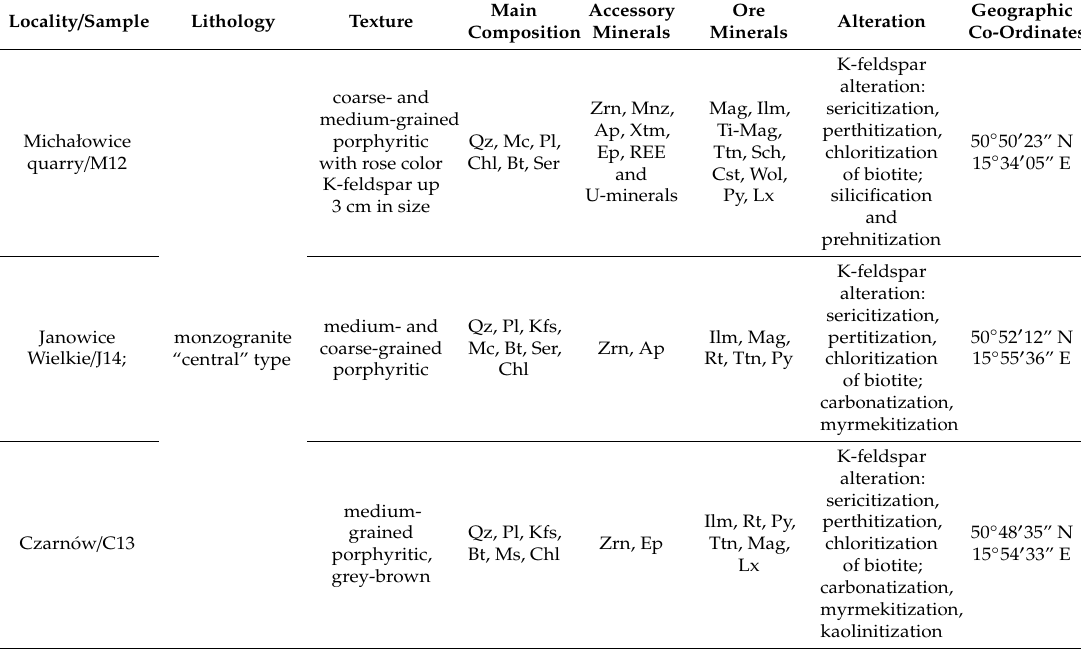
Table A2. Description of igneous rock samples used for SHRIMP zircon U-Pb